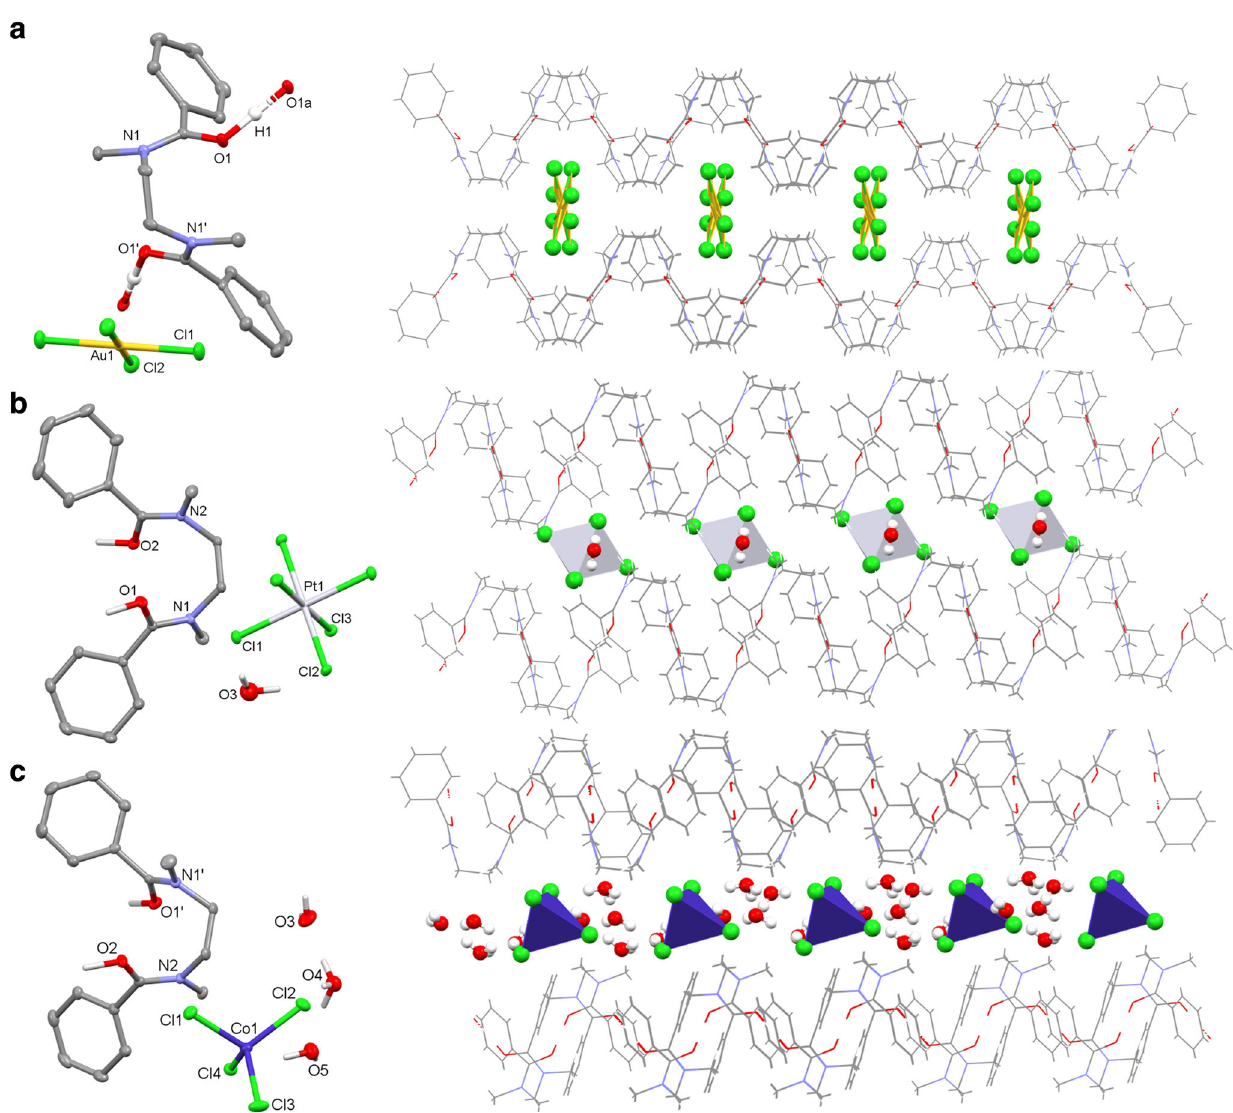
Fig. 2 Structural characterisation of precipitates by X-ray crystallography. For clarity, all hydrogens except those involved in hydrogen bonding are omitted (displacement ellipsoids are drawn at 50% probability). Atom colours: red = O; cyan = N; grey = C; green = Cl; yellow = Au, pale grey = Pt, dark blue = Co; white = H. a X-ray crystal structure of [HL][AuCl 4 ] showing the intermolecular proton-chelate structure and the arrangement of AuCl 4 − within the rhombohedral clefts derived from the phenyl and methyl substituents of the in fi nite chain of protonated diamides, C(H) — Cl(Au) 3.43 – 3.97 Å; N1-C3- C3 ′ -N1 ′ 54.9(3)°. b X-ray crystal structure of [HL] 2 [PtCl 6 ](H 2 O) showing the arrangement of PtCl 6 2 − and a molecule of water within the intermolecular proton-chelated structure. For clarity, only one of the two [HL] cations is shown. c X-ray crystal structure of [HL][H 3 O(H 2 O) 2 ][CoCl 4 ] showing the intermolecular proton-chelate structure and the layered arrangement of CoCl 4 2 − and H 3 O + water cluster between the in fi nite ribbon chain of protonated